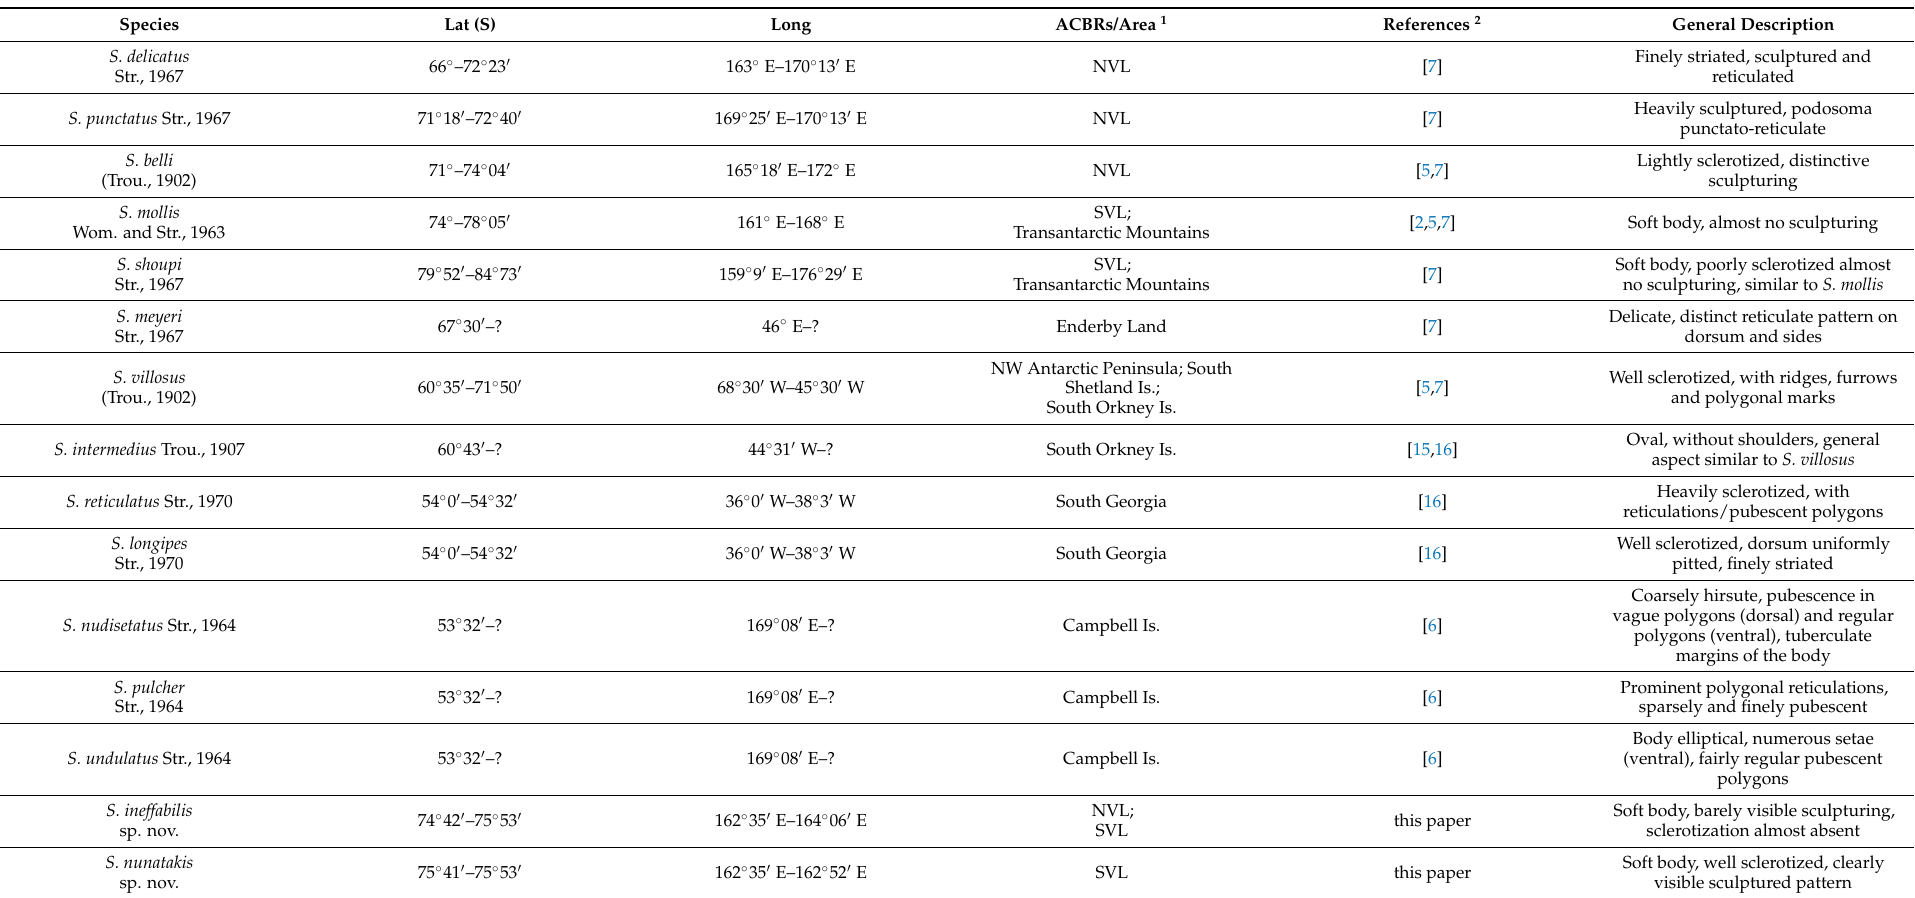
Table A1. Synoptic table of the Antarctic and sub-Antarctic Stereotydeus species with particular attention to the morphological characteristics useful for the identification of the different species. Abbreviations: Trouessart (Trou.); Womersley (Wom.); Strandtmann (Str.) and Pittard